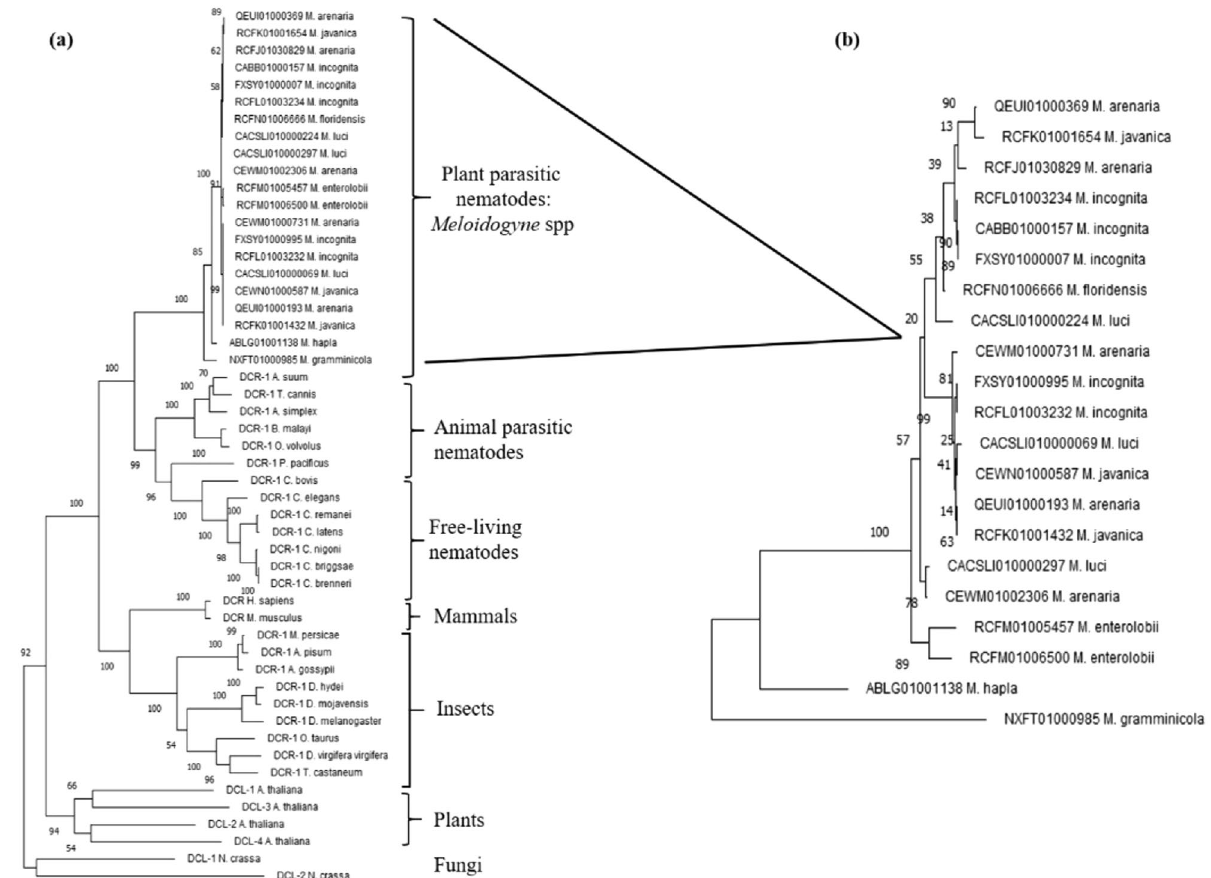
Figure 1. Phylogenetic relationships between DCRs and DCLs of selected eukaryotes. (a) Relationships between predicted DCRs of Meloidogyne spp. and DCRs and DCLs of plants, fungi, insects, mammals and free- living and animal-parasitic nematodes. (b) Relationships between the predicted DCRs of eight Meloidogyne gyne spp. and the changes made to six of the 21 sequences. In all cases, the missing bases were in regions where there was a high likelihood of base miscalling because of a run of the same nucleotides in the sequence. No such correction could be made for the M. hapla and M. graminicola sequences because only one putative contig for a DCR was found in the respective genomes. The curated nucleotide sequences derived from the 21 contigs putatively encode DCRs of varying sizes, between 1,770 and 1,818 amino acids long (Supplementary Table S2, Data S2). Differences in the translated sequences were not only limited to the types of amino acids, but there were also insertions or deletions of up to 28 amino acids (Supplementary Data S2, Supplementary Fig. S1). Notably, the predicted peptides of DCRs of the same species were not identical (Supplementary Data S2, Fig. S1). However, they were more closely related to each other than representative DCRs of free-living and animal parasitic nematodes, mammals, insects, fungi and plants (Fig. 1). Prediction of functional domains and motifs using databases and tools at Pfam, Conserved Domain Database (NCBI) and ScanProsite indicated all the Meloidogyne DCRs had six major functional domains and a motif typical of most characterised eukaryotic DCRs. These were, from the N-terminus, a Helicase ATP binding, a Helicase C terminal, a Dicer Dimerisation, a PAZ, and two Ribonuclease III domains, and a Double- stranded RNA binding motif (Fig. 2). The predicted amino acid sequences of the Ribonuclease IIIb domain and those of the Double-stranded RNA binding motif of the DCRs of the different species were more identical than the other domains; those of the Helicase ATP binding domain were the most diverse (Supplementary Fig. S1). The architecture of the domains confirms the closer relations of the Meloidogyne DCRs to eukaryotic DCRs in general (Fig. 2). However, the differences in the primary (amino acid differences) and secondary structures (arrangement of the domains) of the DCRs encoded by different contigs from different, or the same isolates allowed classification of the DCRs as potentially different proteins. These are indicated in Fig. 2, and the Sup- plementary Table S2 with sub-numerals following the DCRs encoded by the species. The tertiary structure of the Meloidogyne DCRs had the L shape characteristic of DCRs of humans, C. elegans and A. thaliana (Fig. 3) with subtle differences in the folding of the different domains which include the folding of the PAZ and the RNase IIIa domain that eventually determines the sizes of siRNAs cut by the DCRs (Fig. 3).